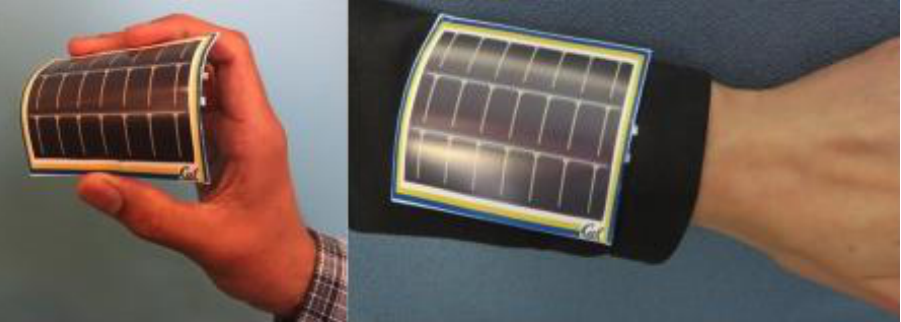
Figure 19. Flexible PV panel, circuit board, and lithium battery [81] (license: CC BY 4.0). A battery, a microcontroller, and an optoelectronic photoplethysmogram sensor